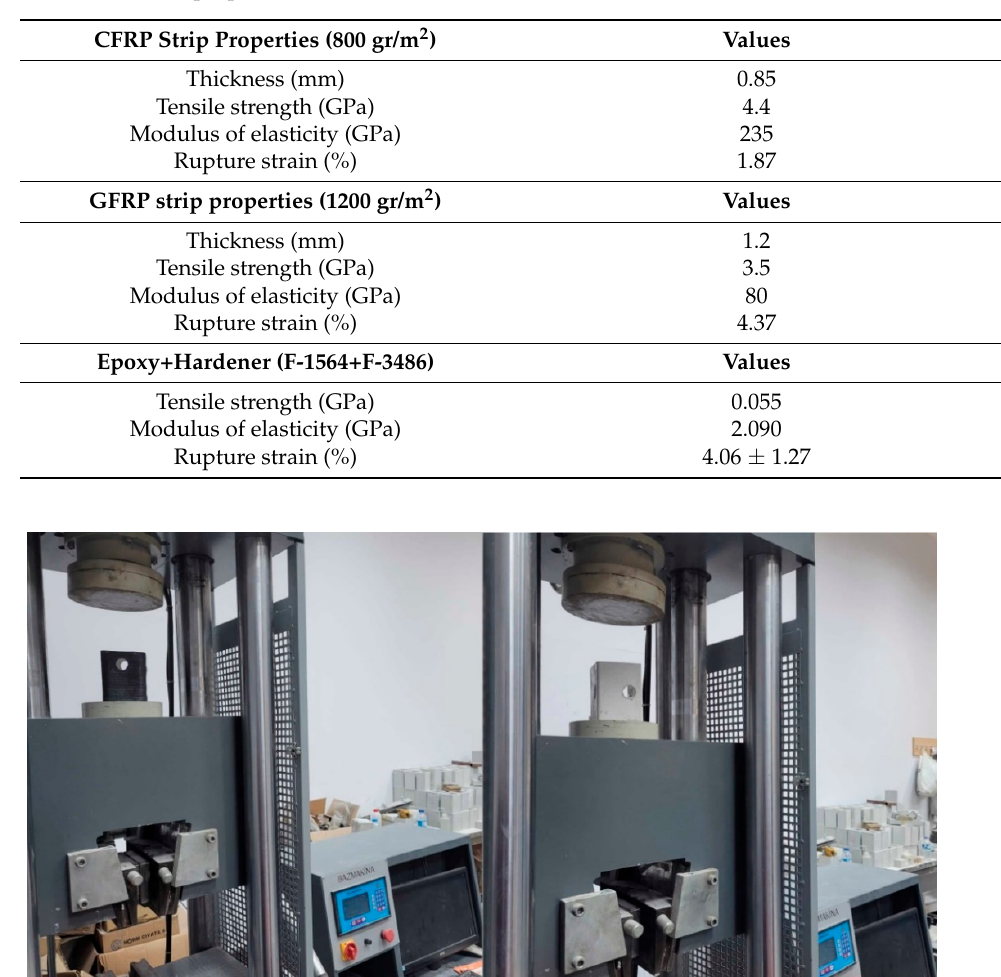
Figure 2. Test setup.